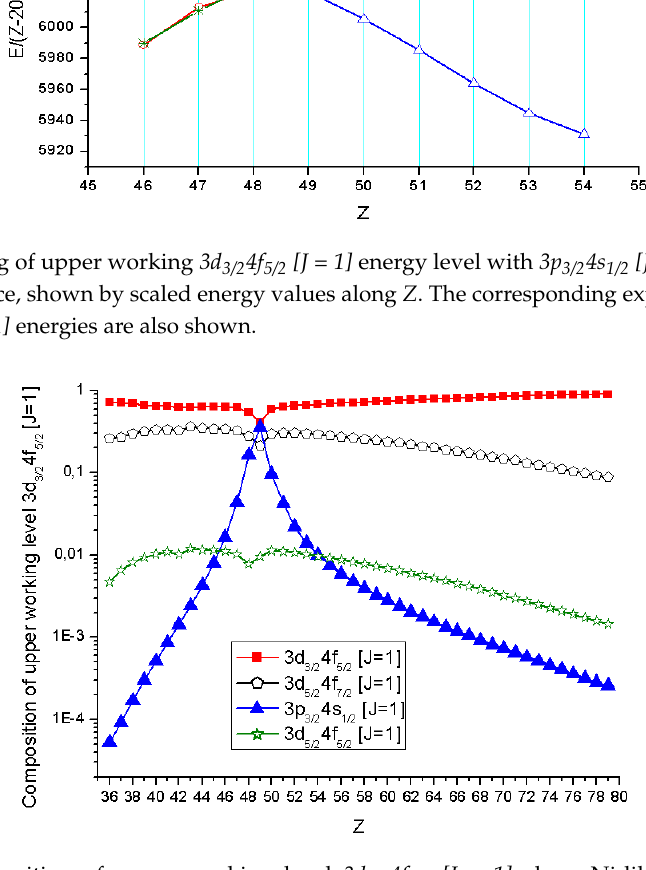
Figure 6. Composition of upper working level 3d 3/2 4f 5/2 [J = 1] along Ni-like sequence on a logarithmic scale.